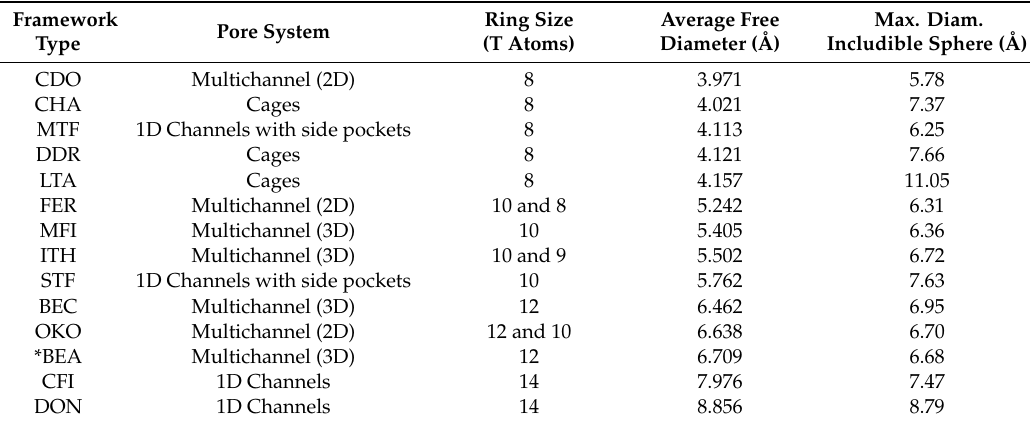
Table 1. Characteristics of the frameworks of zeosils studied for water and LiCl solutions